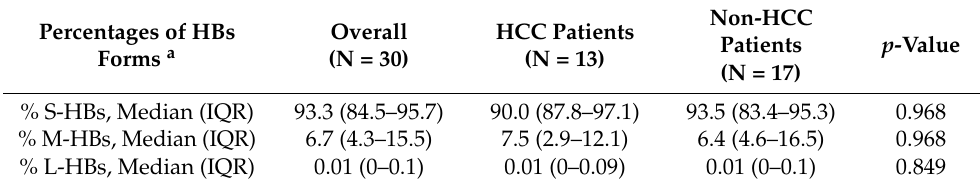
Table 3. Ratios of the different HBs isoforms at T0 in overall population and stratified according to HCC